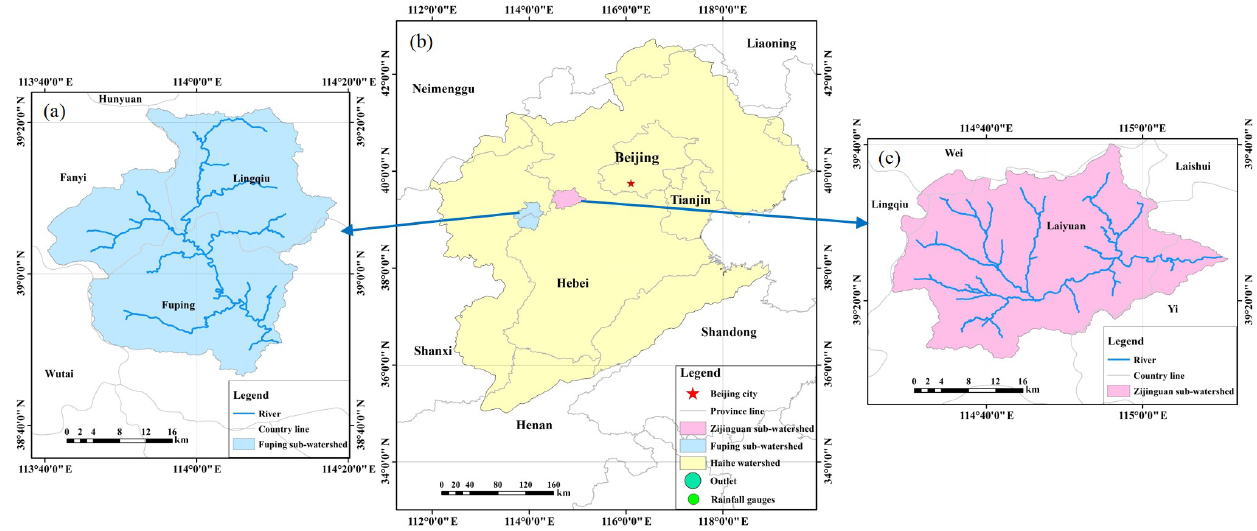
Figure 2. Location map of the two study sub-watersheds.